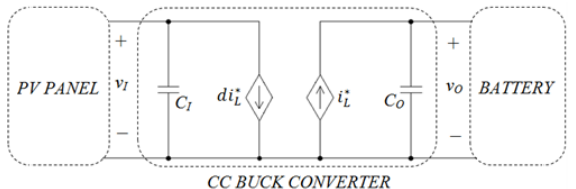
Figure 11. Averaged current-controlled system